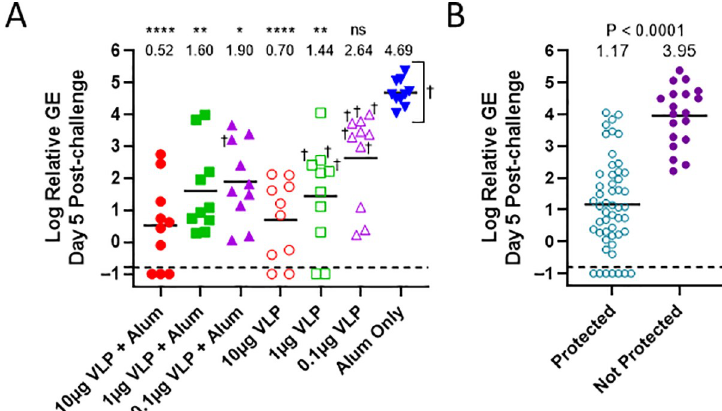
Fig 4. Protection against ZIKV RNAemia following challenge. (4A) Serum was collected on day 5 post-challenge (Study Day 49) for quantification of ZIKV genomes by RT-qPCR. Each sample was analyzed against ZIKV RNA and GAPDH RNA standard curves and the ZIKV genome equivalents (GE) relative to GAPDH were determined and Log 10 transformed. Serum samples with no detectable ZIKV RNA were assigned a Log 10 Relative GE value of -1 for graphing and statistical analysis. Group mean Relative GE levels are shown by line, individual mice shown by symbol, and ‘†’ denotes the individual mice that succumbed to infection. All mice in the alum only (100 μ g) control group died. The dashed line indicates the highest Log relative GE from the sera of 5 na ï ve mice (-0.77) and is shown for comparison. Statistical significance relative to the alum only group by Kruskal-Wallis test followed by Dunn’s pairwise comparison tests are denoted as: ���� P < 0.0001, ��� P < 0.001, �� P < 0.01, � P < 0.05, or ns (not significant). All possible pairwise comparisons were performed and there were no statistically significant differences among VLP groups. (4B) Log 10 relative ZIKV GE on Study Day 49 (day 5 post-challenge) were plotted compared to mice surviving (protected) and mice succumbing to infection (Not Protected). Group mean Log 10 Relative GE are denoted by line, individual titers by symbols, the maximum na ï ve mouse value by a dashed line as in Fig 4A, and P value was calculated by Mann-Whitney U test.